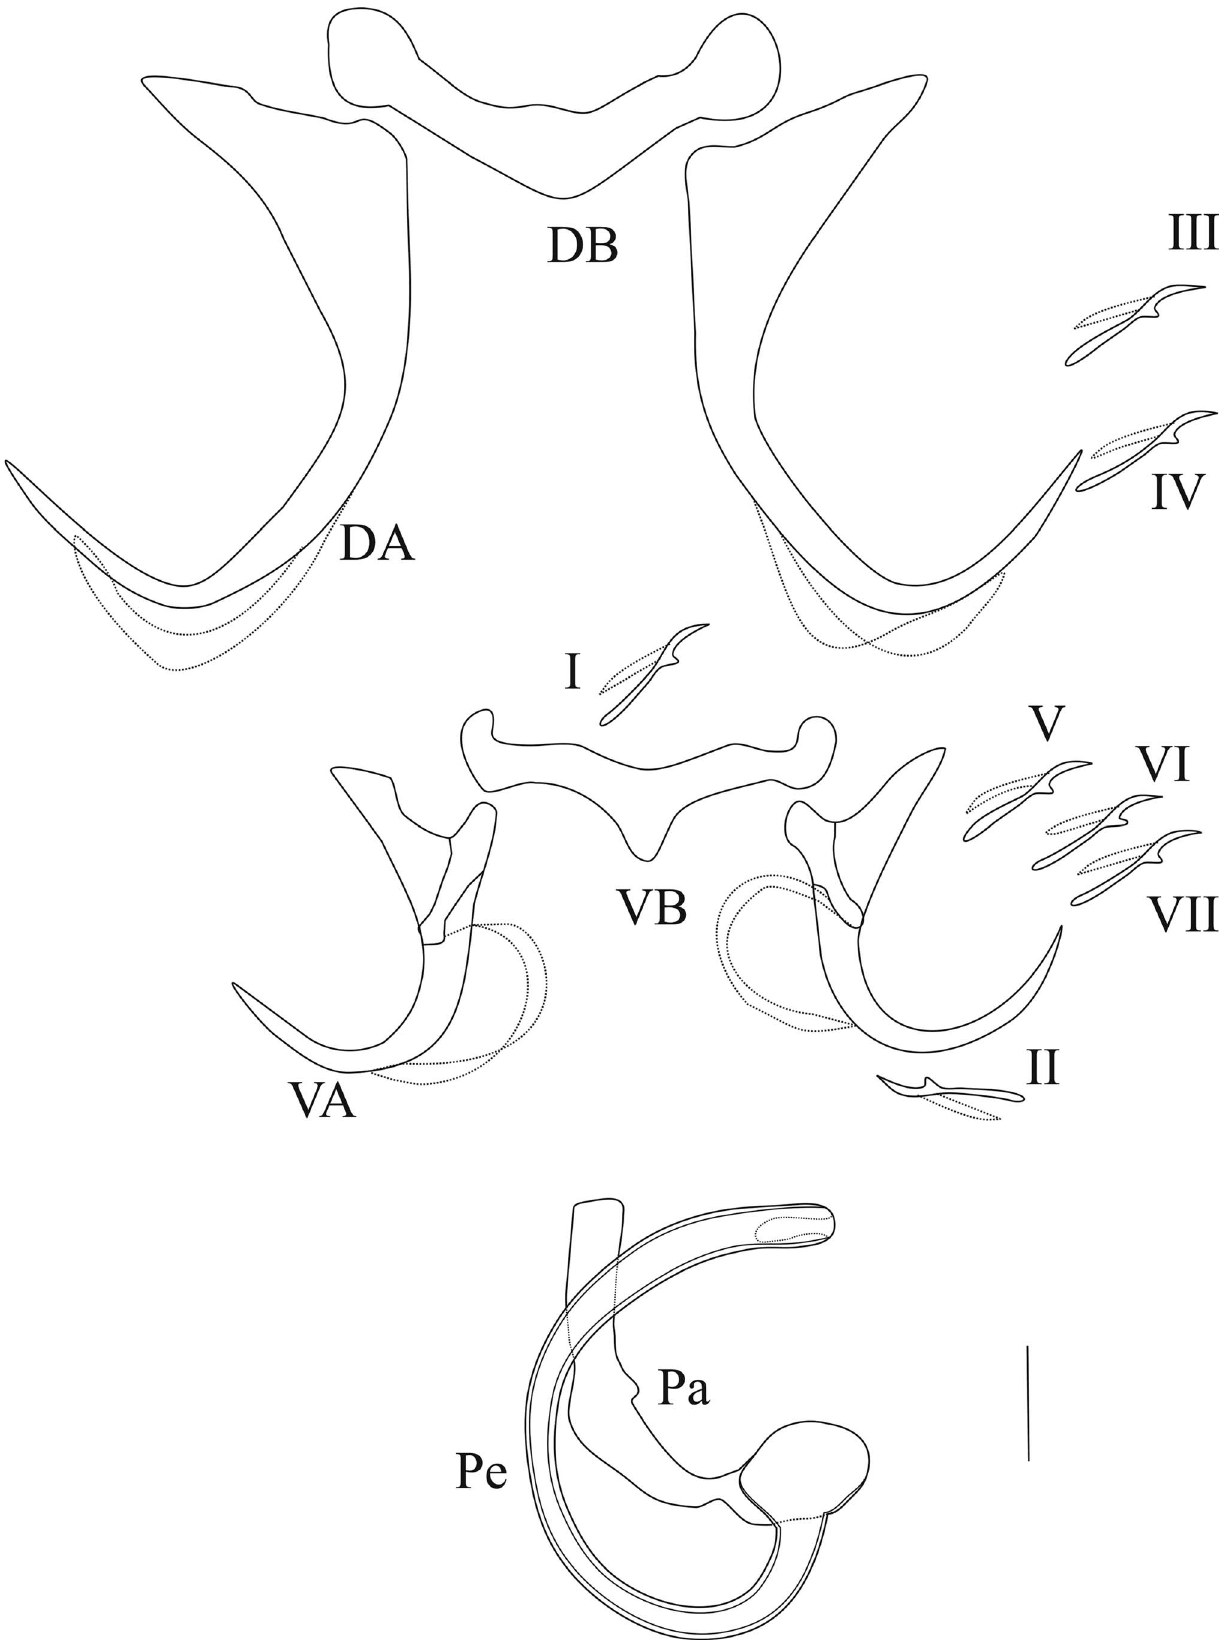
Figure 4. Hard parts of Synodontella bagoueensis: D.A: dorsal anchor; D.B: dorsal transverse bar; V.A: ventral anchor; V.B: ventral transverse bar; I – VII: marginal hooks; Ap: accessory piece; Pe: penis. Scale bar = 10 l